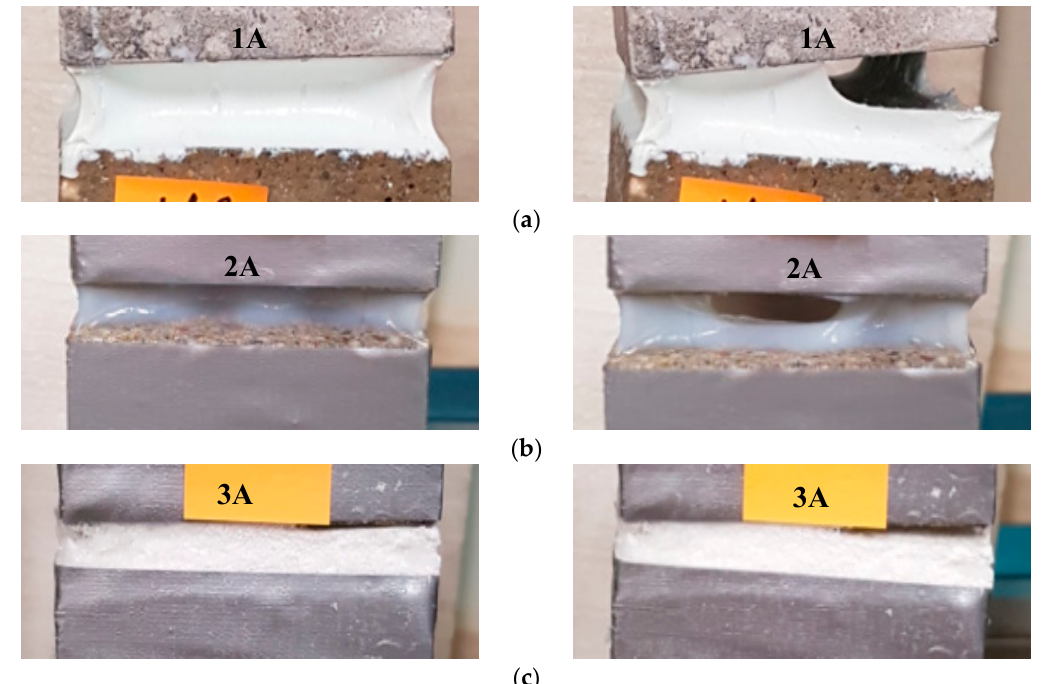
Figure 12. Examples of specimens of resins filling the expansion joints before and after the loss of adhesion to the surface (point f 0 X ) in an axial tensile test: ( a ) resin 1A, ( b ) resin 2A and ( c ) resin 3A.